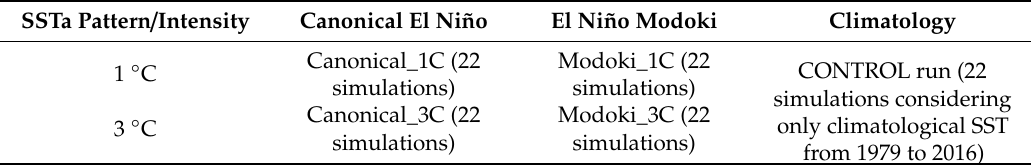
Table 4. Summary of the experiments performed with the Atmosphere General Circulation Model